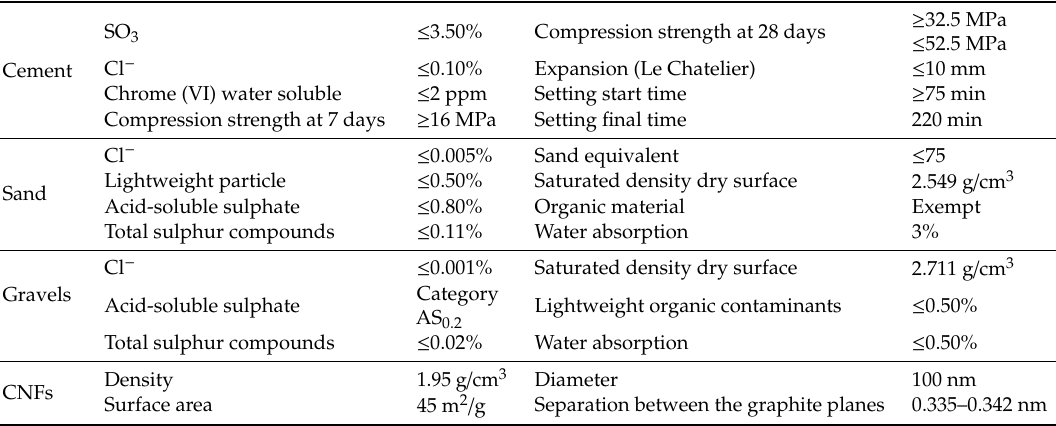
Table 1. Chemical composition and physical characteristics of the cement, sand, gravel and carbon nanofibers (CNFs).